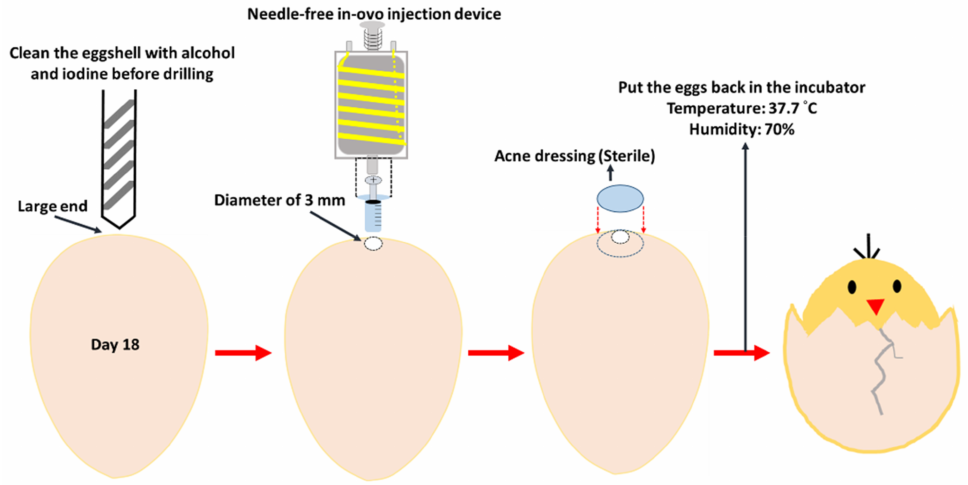
Figure 2. Needle-free in ovo injection procedure of embryonic eggs on day